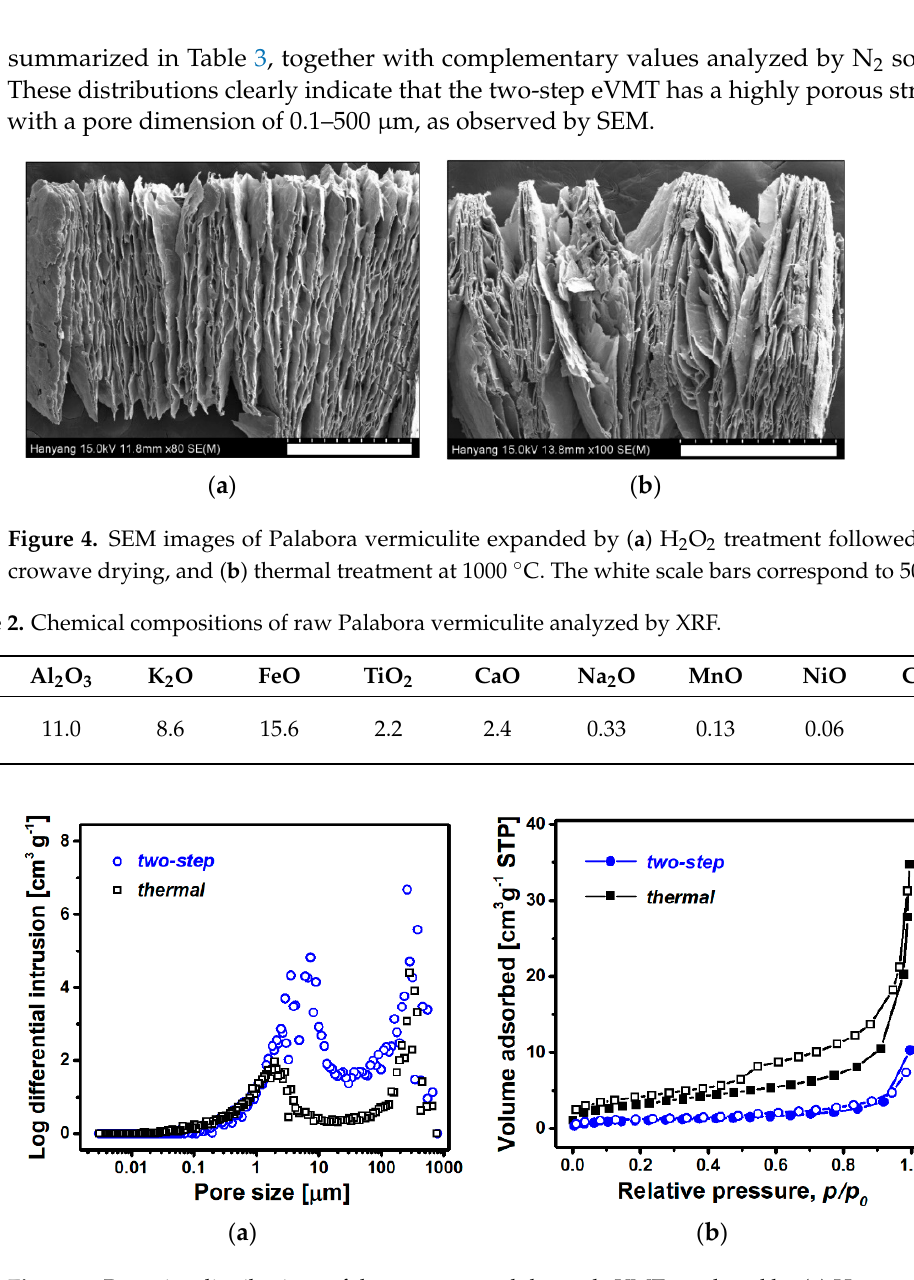
Figure 5. Pore-size distributions of the two-step and thermal eVMTs analyzed by ( a ) Hg porosimetry and ( b ) N 2 sorption. Table 2. Chemical compositions of raw Palabora vermiculite analyzed by XRF. Table 3. Summary of the porosity characteristics of the two eVMTs probed by Hg porosimetry and N 2